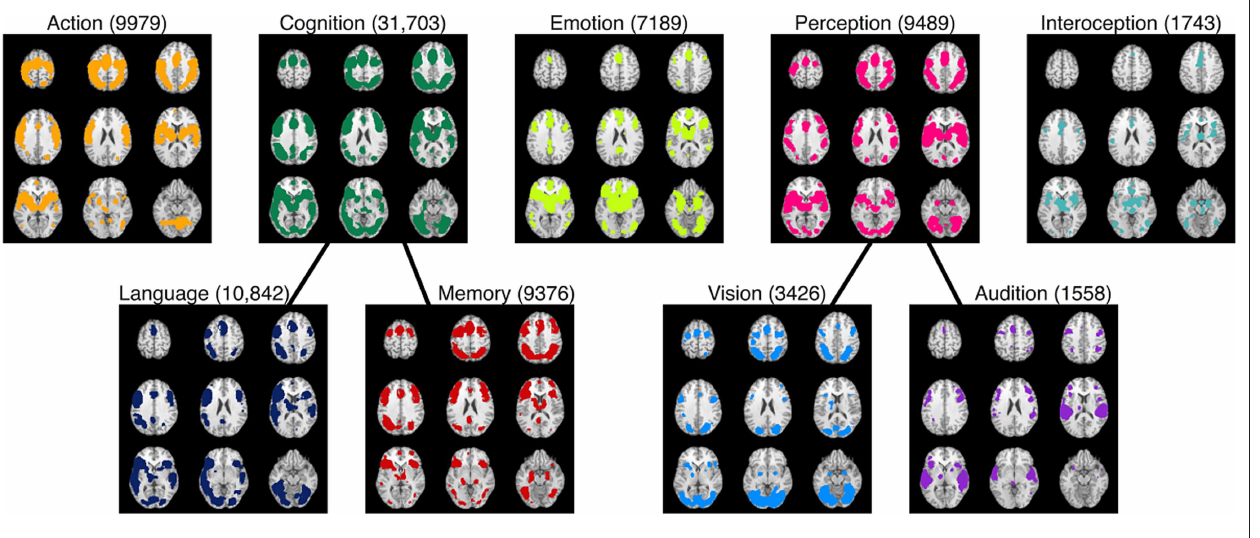
FIGURE 8 | BrainMap’s functional atlas development strategy. ALE meta- analyses were performed on nine arbitrarily selected behavioral domain categories and sub-categories: action, cognition, emotion, perception, interoception, language, memory, vision, and audition. These results illustrate the mapping of function-to-regions correspondences that are currently